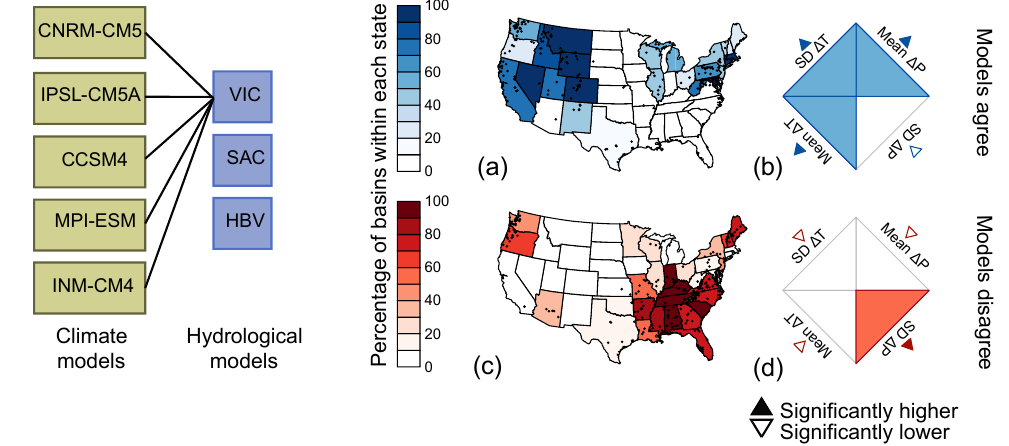
Figure 8. Spatial distribution of the basins in which Variable Infiltration Capacity model (VIC) simulations driven by the five climate models agree on the sign of change in discharge timing (a) , and disagree on the sign of change (c) . The rose plots (b, d) show standardized climate change characteristics for catchments shown in (a) and (c) , respectively. The “SD (cid:49)T ” ( P ) stands for the standard deviation of the projected change in temperature (precipitation) for the five different climate models; “mean (cid:49)T ” ( P ) is the mean projected change in temperature (precipitation) of the five different climate models. The characteristics in the rose plots have been standardized from 0 to 1, where 0 represents the lowest value of the characteristics for the two displayed groups, and 1 the highest value of the characteristics for the two displayed groups. Left panel: combination of climate model and hydrologic model (VIC: Variable Infiltration Capacity model; SAC: Sacramento Soil Moisture Accounting model; HBV: Hydrologiska Byråns Vattenbalansavdelning model) for which the results are